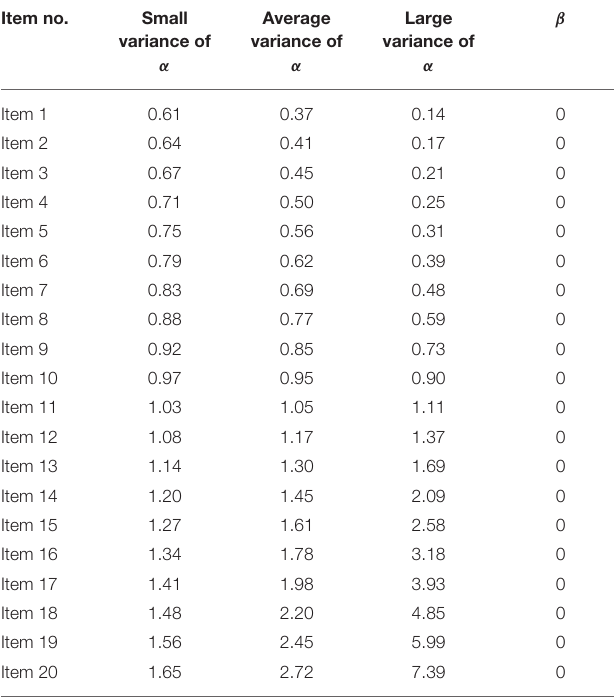
TABLE 3 | Item Parameters used to Generate the Item